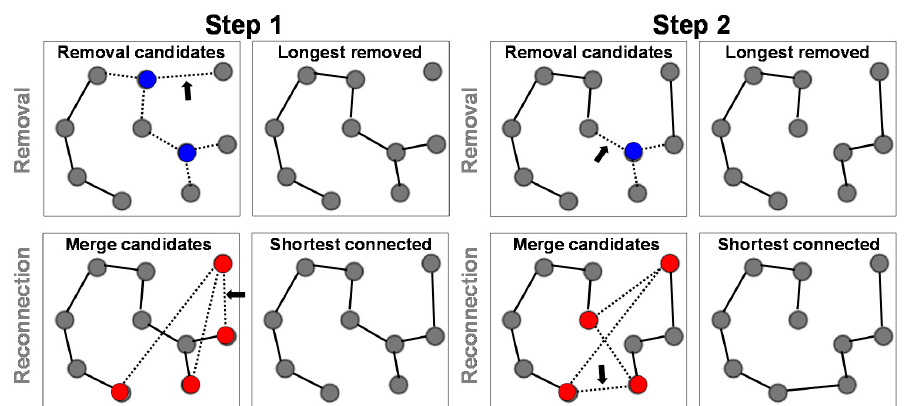
Figure 9. Example of the greedy variant of MST-to-TSP. At each step, the longest remaining branch link is removed. The two trees are then merged by selecting the shortest of all pairwise links across the trees.